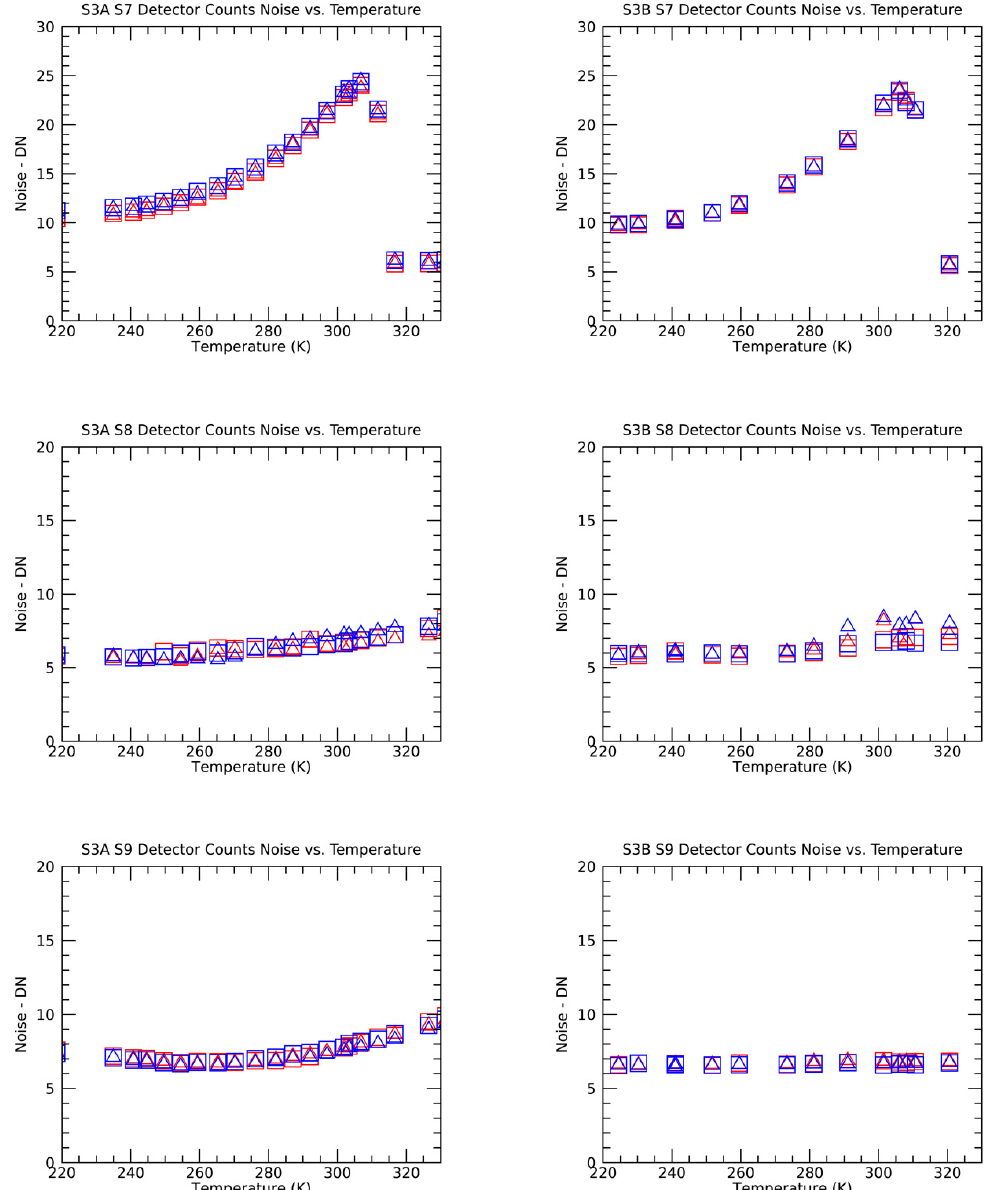
Figure 6. Detector noise in counts vs. brightness temperature for SLSTR-A (left) and SLSTR-B (right) nadir view for channels S7–S9. The values for the oblique view are not shown as they are very close to the values for the nadir view. ☐ = Detector 1, Integrator 1; ☐ = Detector 1, Integrator 2; Δ = Detector 2, Integrator 1; Δ = Detector 2, Integrator 2.